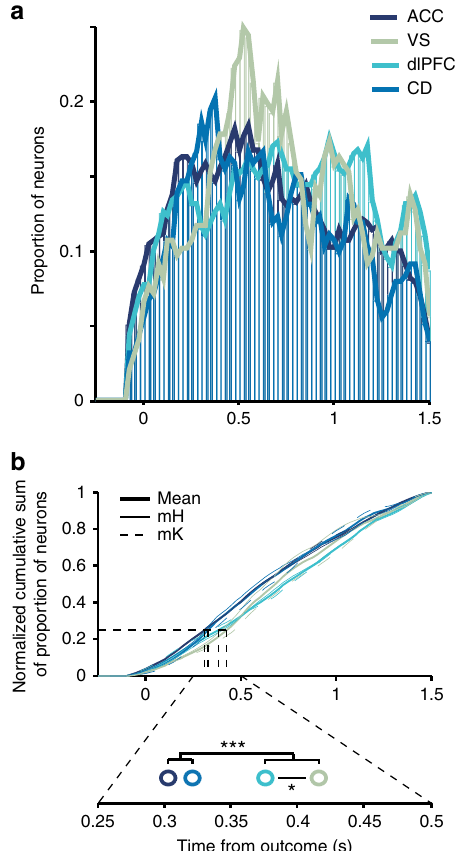
Fig. 5 Latency comparison of feature-speci fi c RPE encoding across areas. a Histogram of the proportion of feature-speci fi c RPE encoding units in ACC, VS, dlPFC, and CD combined in time across both monkeys. For each neuron, all time bins for which an RPE was encoded are included ( n ACC = 256; n VS = 132; n dlPFC = 234; n CD = 152). To enhance visualization of the four histograms lines representing the outlines of each histogram are added. b Normalized cumulative sums of the histograms in ( a ). Top: Thick lines represent the mean across both monkeys, while thin continuous lines represent cumulative sums of monkey H, and thin dotted lines represent cumulative sums of monkey K. The cumulative sums of all areas except for ACC and CD differed signi fi cantly from each other (Kolmogorov – Smirnoff test, Bonferroni – Holm multiple-comparison correction; p ACC-CD = 0.128, all other p < 0.01). Bottom: Magni fi cation of the cumulative sums around the 25% window. Open circles represent the time points at which 25% of feature-speci fi c RPEs are encoded in the four areas. One asterisk indicates p < 0.05; three asterisks indicate p < 0.001 (randomization procedure). Hedges ’ g effect sizes for the latency differences: d ACC-dlPFC = − 0.18, d